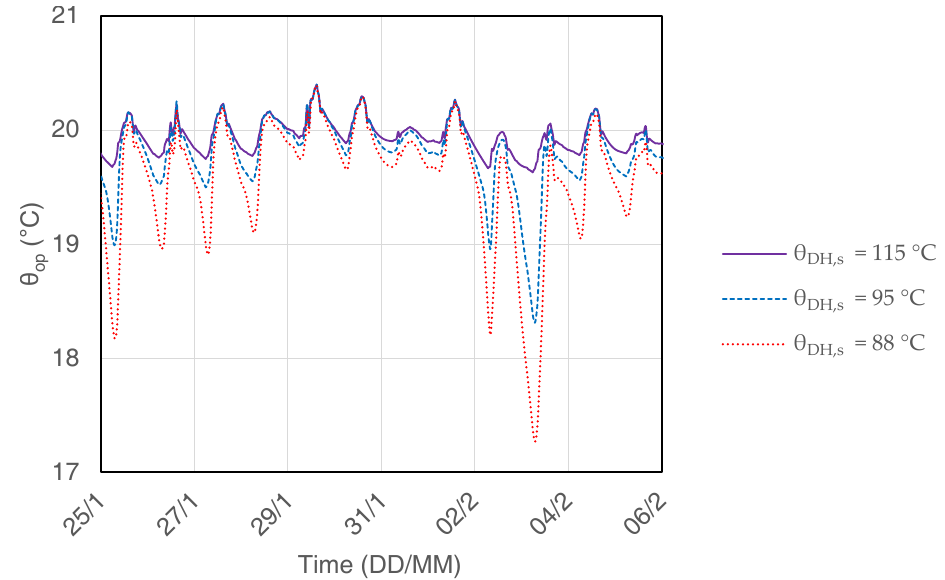
Figure 8. Indoor operative temperature in a winter period for a single family house built between 1961 and 1975 at different DH supply temperatures. Original design temperature: θ DH = 115 ◦ C. Operative temperature set-point: 20.5 ◦